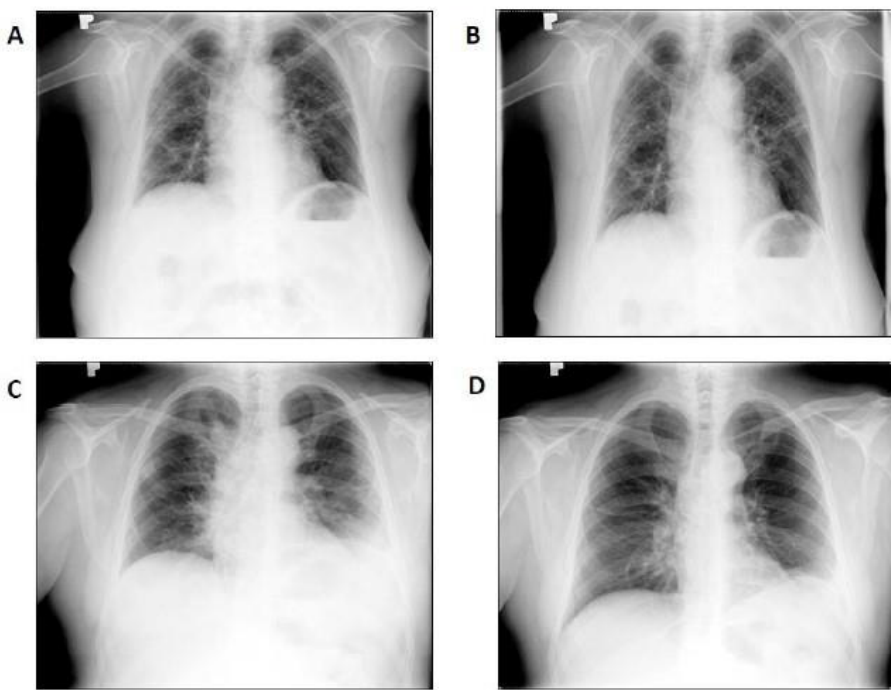
Figure 4. Chest radiographs of first two consecutive patients with COVID-19-associated pneumonia included in the study prior to and 14 days after LDRT procedure showing radiological improvement. (( A )—patient #1 baseline, ( B )—patient #1 day 14, ( C )—patient #2 baseline, ( D )—patients #2 day 14).